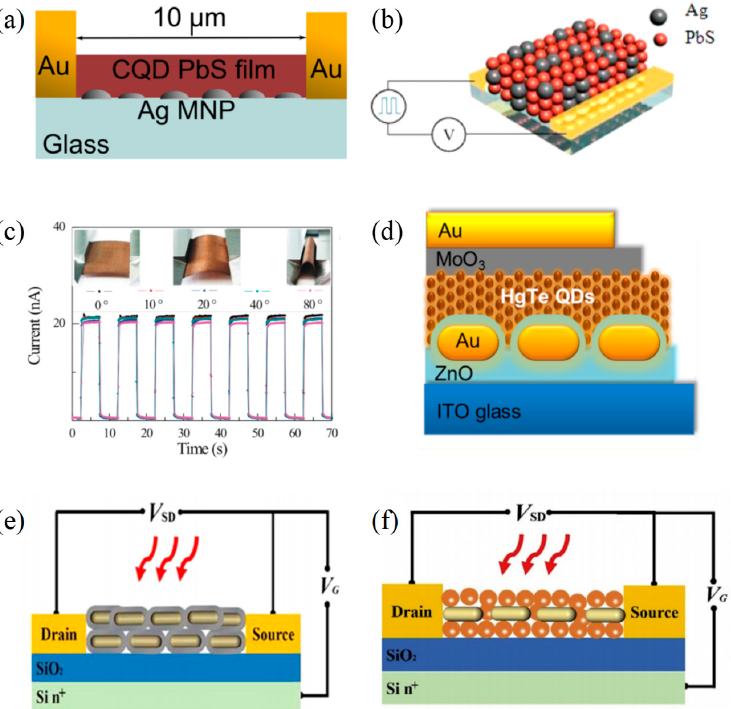
Figure 10. Structures and performance characterization of 0D materials-based infrared PDs with nanoparticles. ( a ) Schematic of the PD device structure with embedded nanoparticles [78]. Copyright 2012, Applied Physics Letters . ( b ) Schematic demonstration of device configuration. Red spheres represent PbS CQDs, and black spheres represent Ag NCs. ( c ) Paper-based PDs through many cycles of bending and unbending at wide angles (20–80 ◦ ). The inset shows device photographs of the bending state [79]. Copyright 2014, ACS Photonics . ( d ) Schematic diagram of the